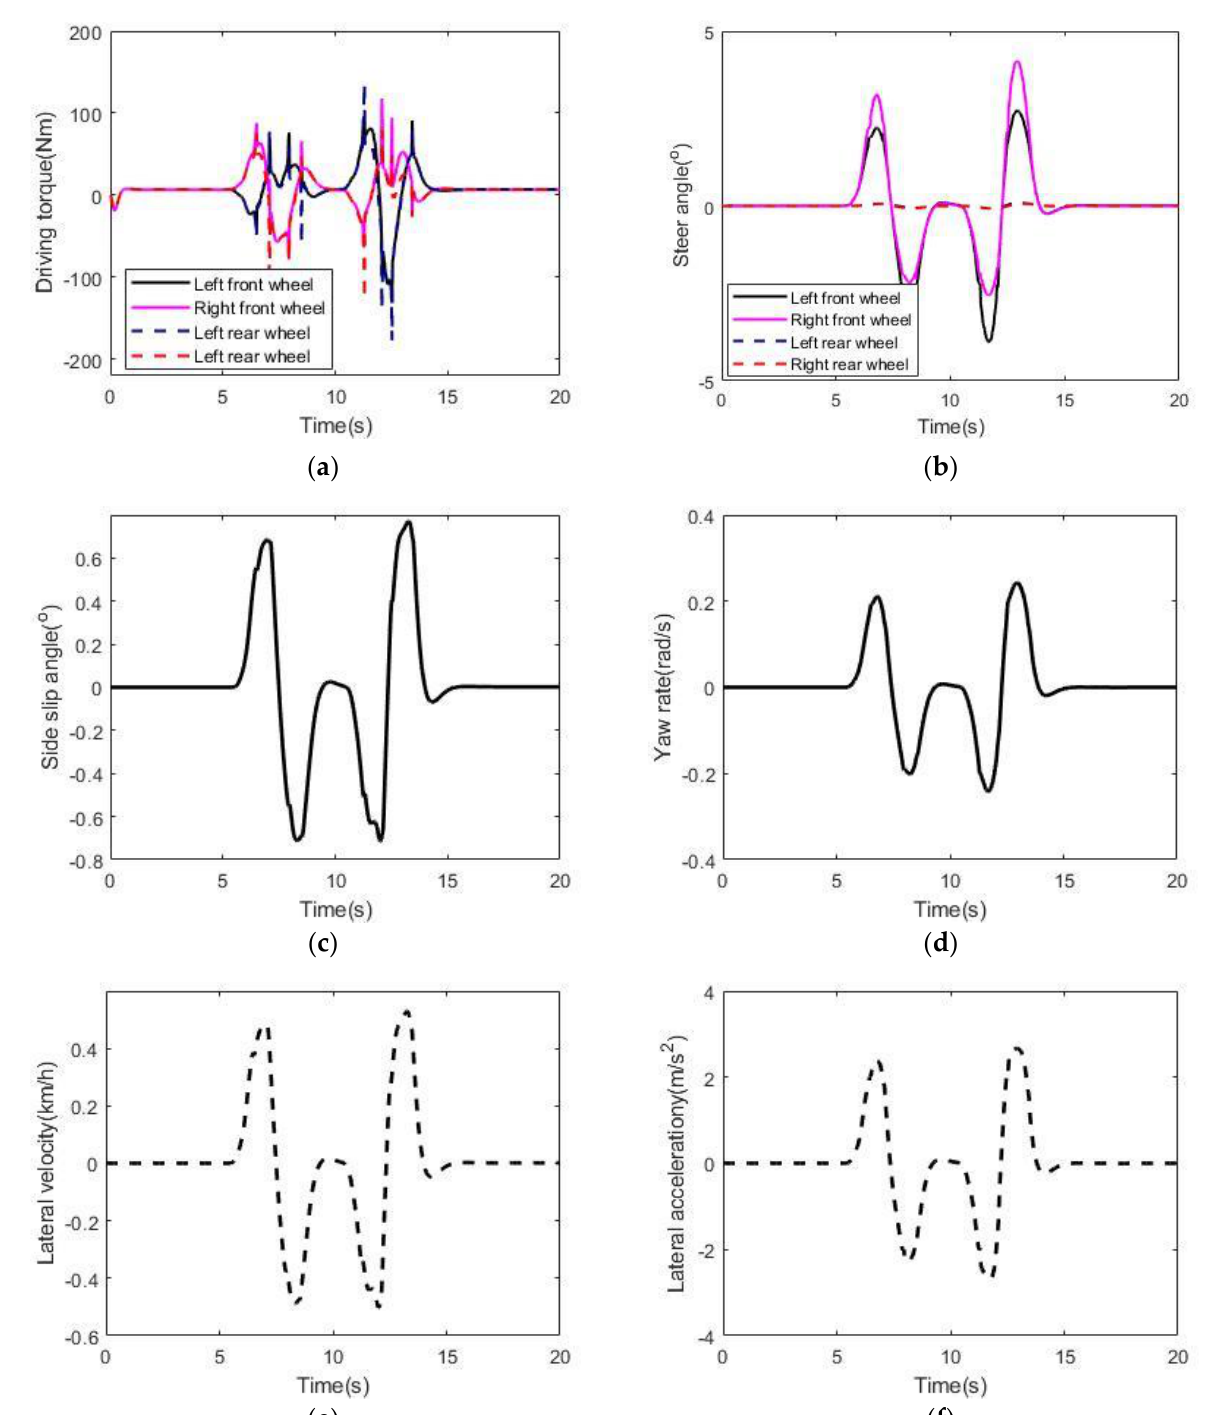
Figure 8. Vehicle state: ( a ) driving torque; ( b ) steer angle; ( c ) side slip angle; ( d ) yaw rate; ( e ) lateral velocity; ( f ) lateral